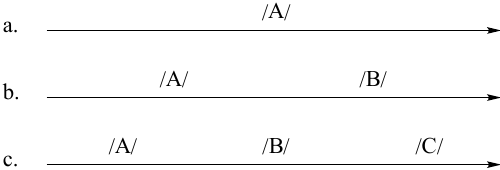
Figure 23: Typically dispersed phonological